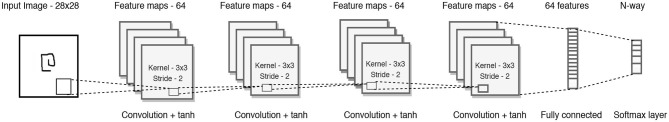
The convolutional architecture used as the baseline. The modulatory trace is applied to the weights connecting the fully connected feature vector to the N-way softmax layer.